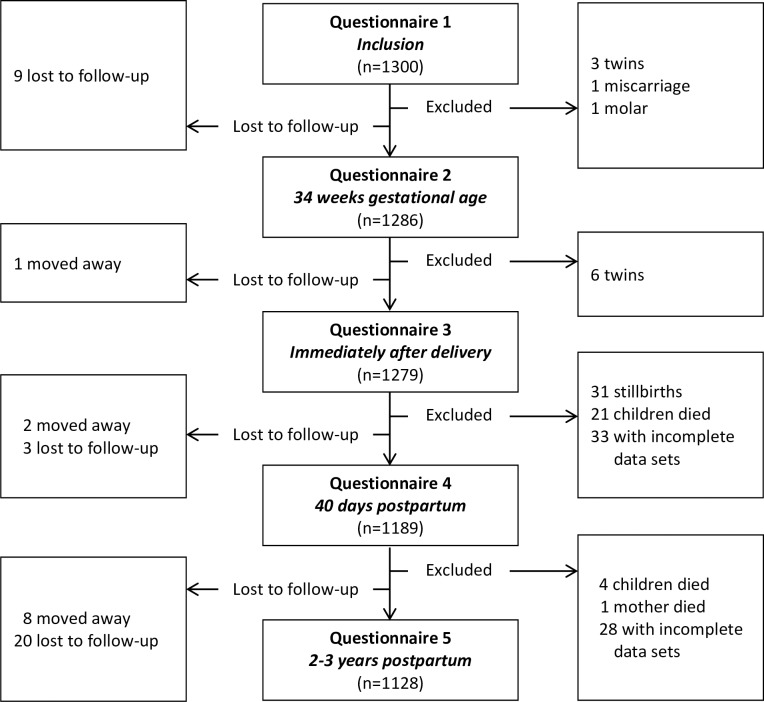
Inclusion flowchart.